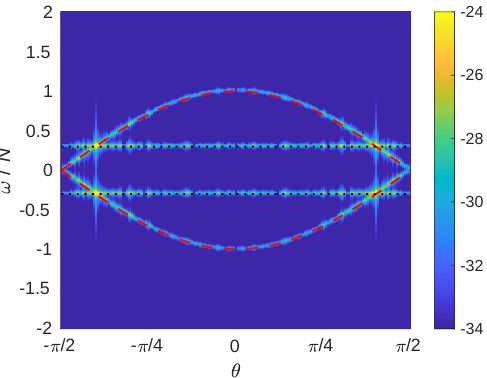
Figure A1. Concentration of energy density E ( θ , ω ) in the ( θ , ω ) Fourier domain (in log scale) for the Saint Andrew’s cross pattern. A Hann window was applied to the signal in the time domain for the same data as in Figure 3b. Red dashed line: dispersion relation curve ω r ( θ ) for internal gravity waves defined by Equation (2). Back dotted line: forcing frequency ω f